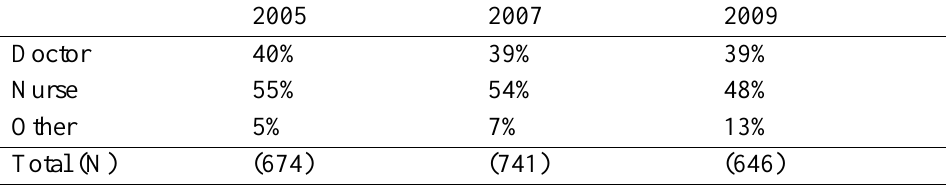
Professional background of department managers from 2005 to 2009